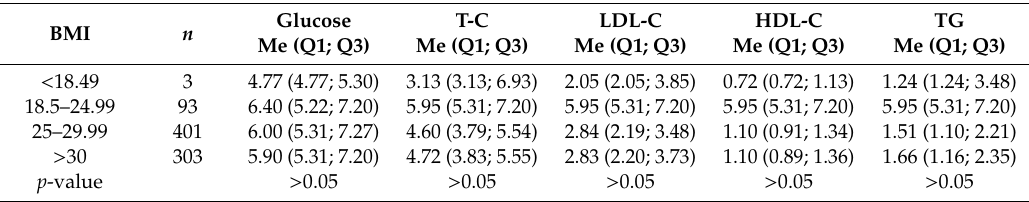
Table 10. Kruskal–Wallis rank ANOVA analysis by BMI